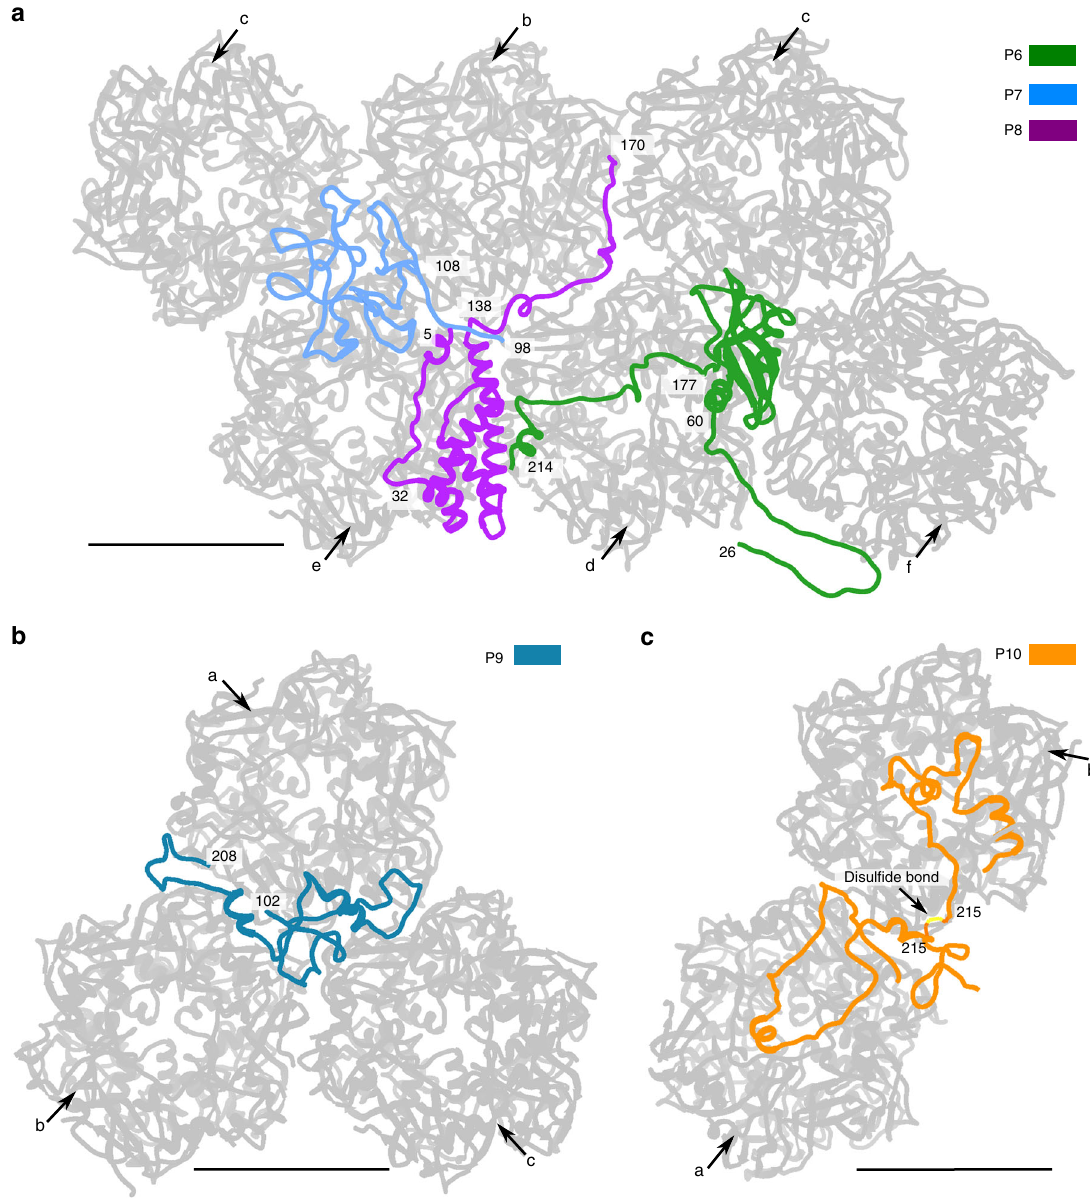
Fig. 4 Structures of the minor capsid proteins that glue together capsomers within each pentasymmetron. The minor capsid proteins and their neighboring capsomers are shown as ribbon diagrams. All the capsomers are colored gray and labeled as in Fig. 1c. a Minor capsid proteins P6, P7, and P8. b Minor capsid protein P9. c Minor capsid protein P10. Scale bars, 50